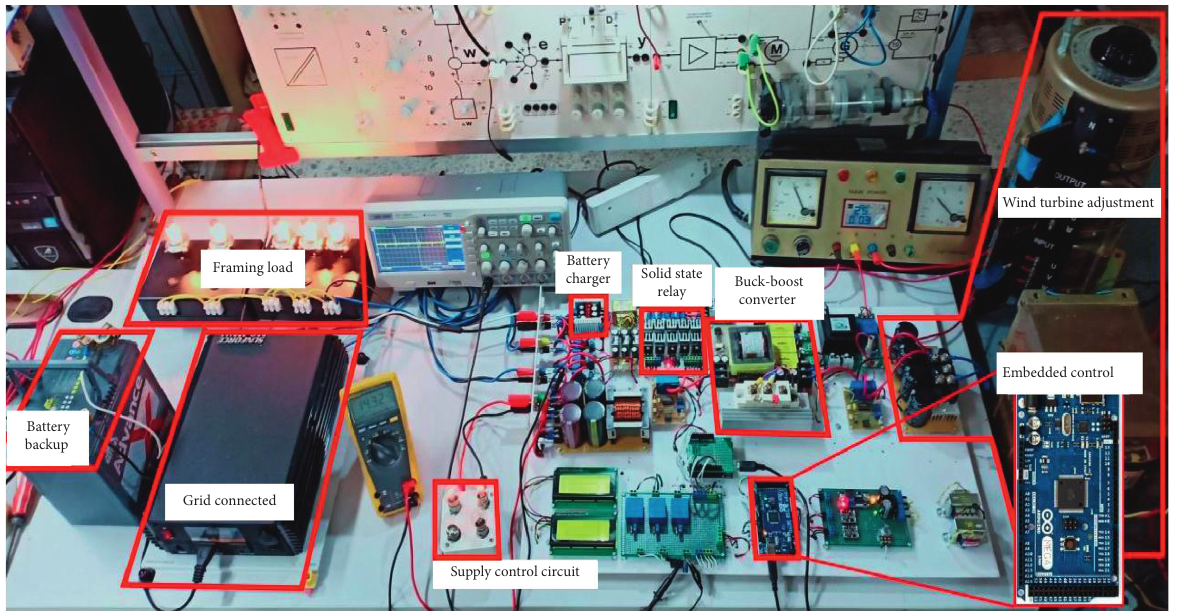
Figure 16: Experimental setup of intelligent control of the PI controller based on a buck-boost